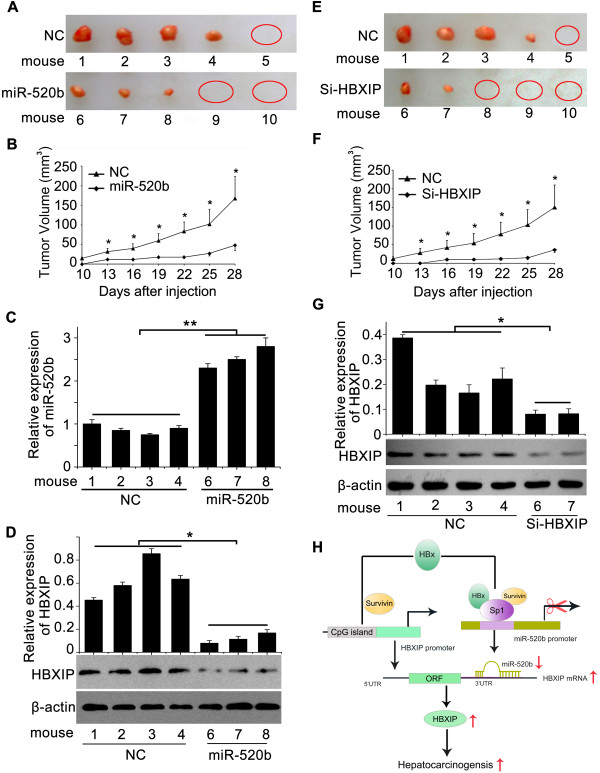
MiR-520b/HBXIP modulates growth of LO2-X-S cells in vivo. (A-G) The effect of miR-520b or si-HBXIP on the growth of LO2-X-S cells was detected by xenograft assay. The expression levels of miR-520b and HBXIP in the tumor tissues from mice (n = 5, each group) were determined by qRT-PCR or western blot analysis, respectively. Data are shown as mean ± SD of three independent experiments (*P < 0.05, **P < 0.01, Student’s t test). (H) A model of HBx accelerating hepatocarcinogenesis with partner survivin.